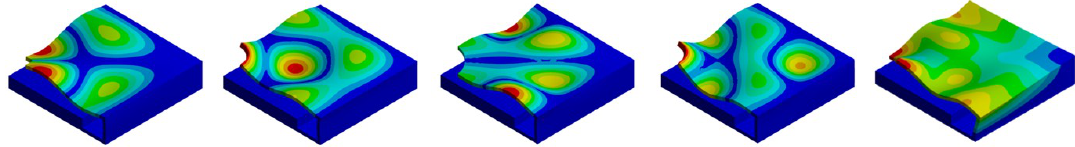
Figure 19. Five package modes for case (b): 5th mode shape at 78.86 ( left ), 6th mode shape at 85.02 kHz ( center-left ), 7th mode shape at 103.45 kHz ( center ), 8th mode shape at 110.32 kHz ( center-right ), 13th mode shape at 136.14 kHz ( right )).